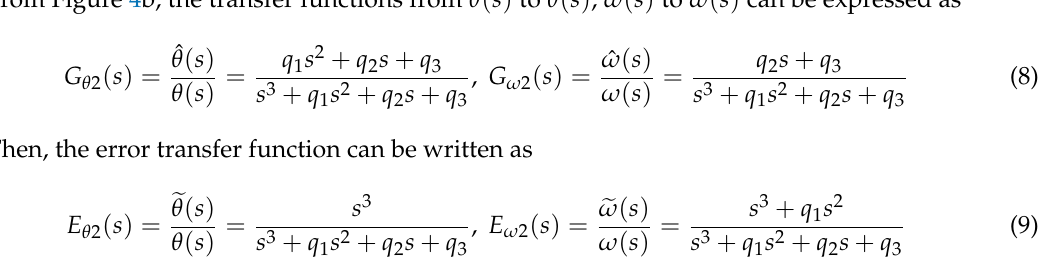
Figure 4. Block diagram of the Type III PLL design for demodulation. ( a ) Actual form; ( b ) Simplified form.